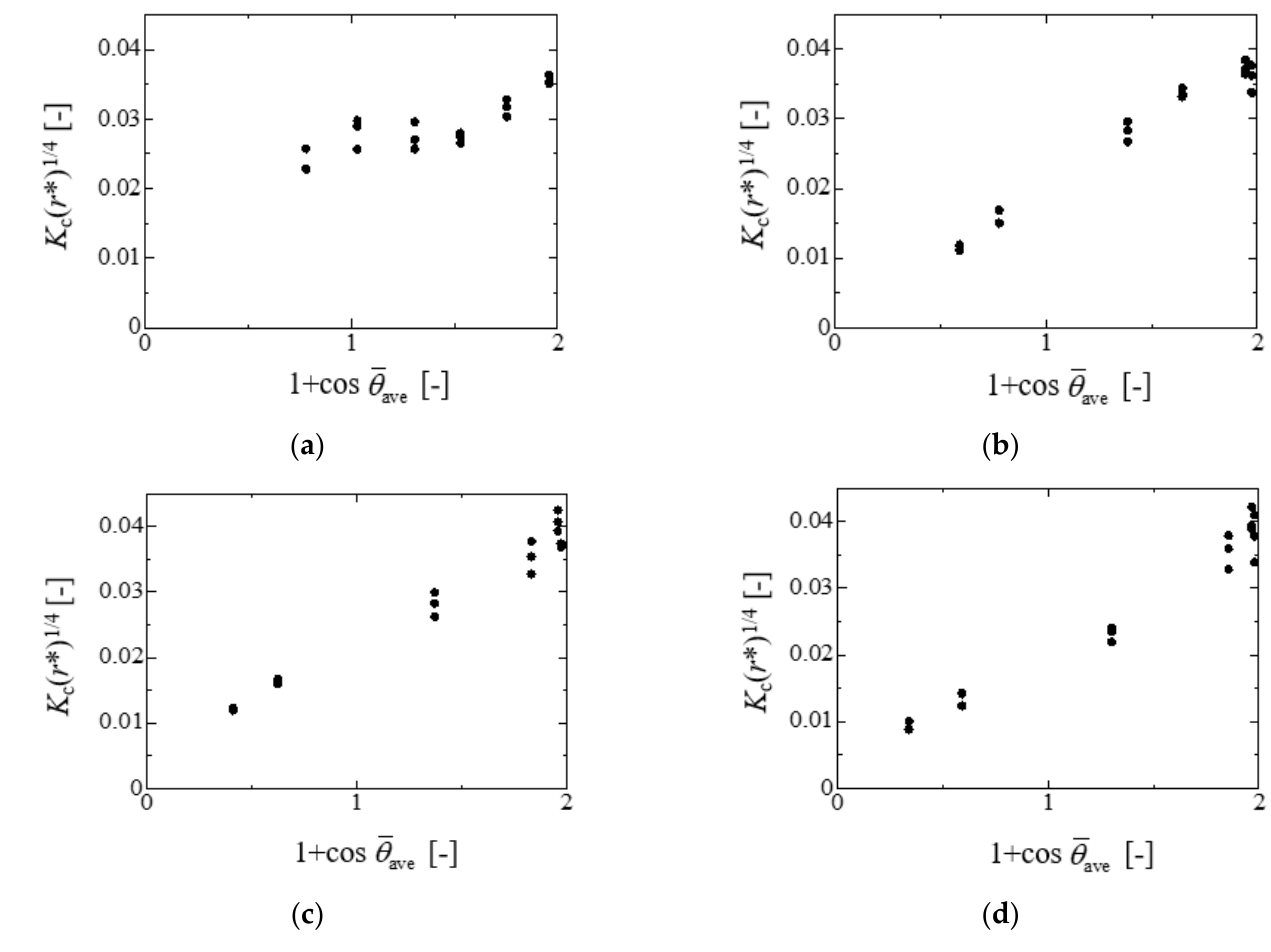
Figure 5. Relationship between the splashing condition K c and the contact angle: ( a ) bare substrate; ( b ) #400 substrate; ( c ) #240 substrate; and ( d ) #120 substrate. The contact angle θ ave is calculated by averaging the static contact angle and the contact angle where the dimensionless contact area diameter reaches the stationary condition after the impingement.